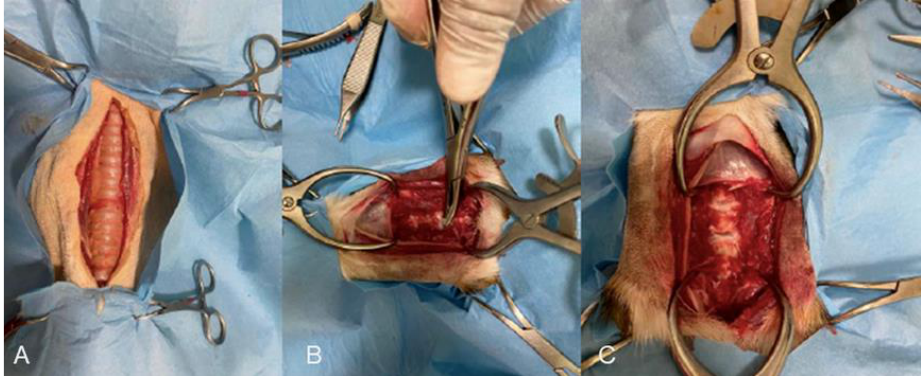
Figure 1. (A) Before, (B) during, and (C) after the ventral slot procedure to remove two intervertebral 127 disks and the dorsal longitudinal ligament. disks and the dorsal longitudinal